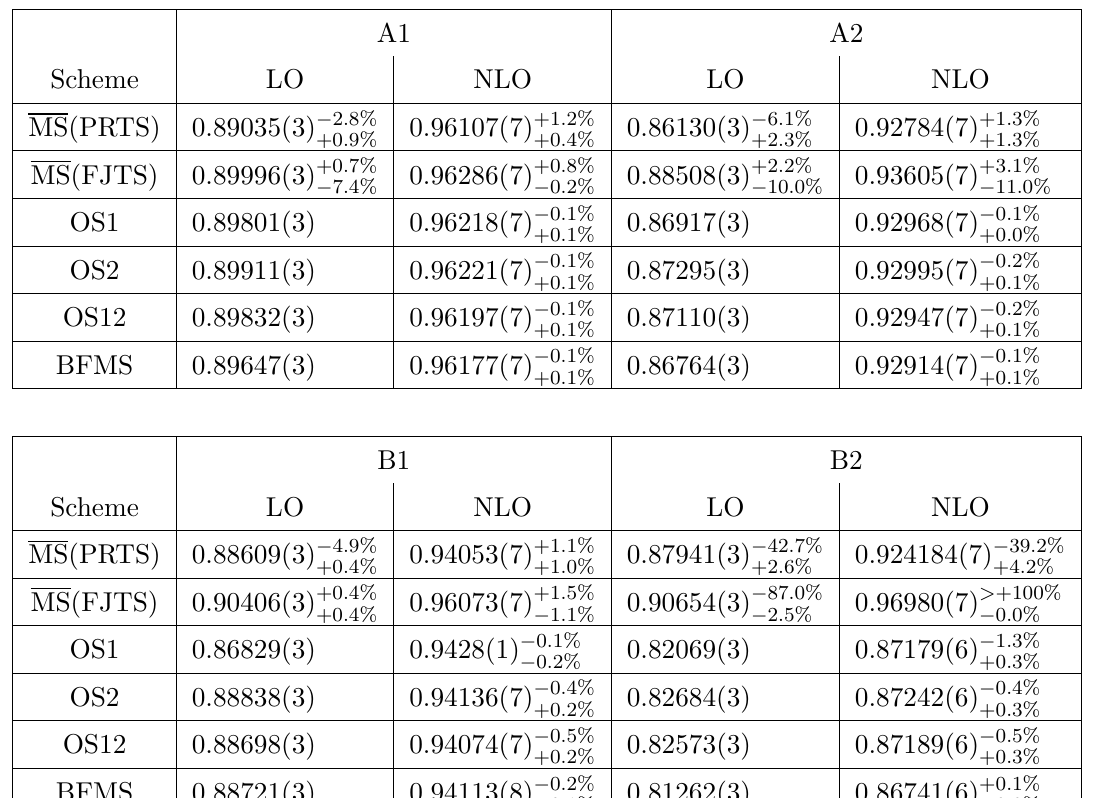
Table 7 . LO and NLO decay widths (cid:0) H 2 ! 4 f [MeV] of the light CP-even Higgs boson H 2 of the THDM for various scenarios in di(cid:11)erent renormalization schemes, with the OS12 scheme as input scheme (and full conversion of the input parameters into the other schemes). The scale variation (given in percent) corresponds to the scales (cid:22) = (cid:22) 0 = 2 and (cid:22) = 2 (cid:22) 0 with central scale (cid:22) 0 = ( M H + M H + M A + 2 M ) = H + 2 1 0